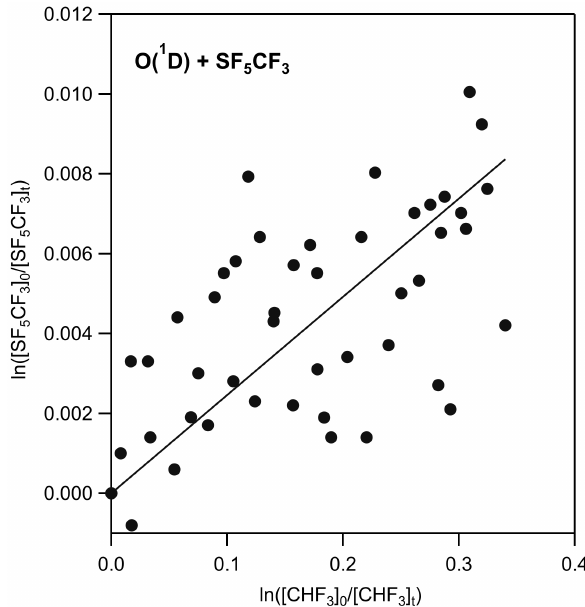
Fig. 5. Relative rate data for the O( 1 D) + SF 5 CF 3 reaction at 296 K with CHF 3 as the reference compound. The uncertainty in the individual data points was estimated to be ± 1% of the initial re- actant concentration and are not included for improved clarity. The line is a linear least-squares fit to the data which yields a reactive branching ratio of 0.0246 ± 0.0029, where the uncertainty is from the precision of the fit (see Table